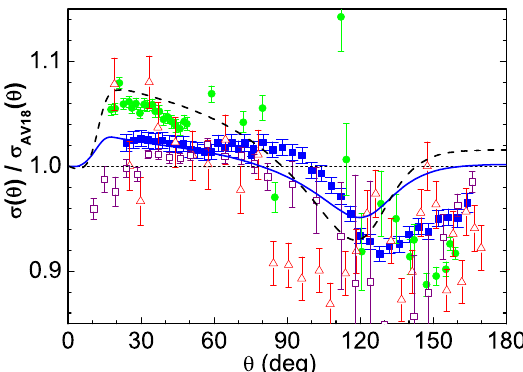
Fig. 4. Ratio of di ff erential cross section of the pd elastic scatter- ing at E p = 10 . 0 MeV to calculation with the AV18 potential. The solid curve denotes the calculation with AV18 + BR 660 , and the dashed curve that with AV18 + BR 800 + V πσ . Experimental data are taken from Ref. [15] (open squares), Ref. [16] (triangles), Ref. [17] (circles), and Ref. [18] (solid squares).